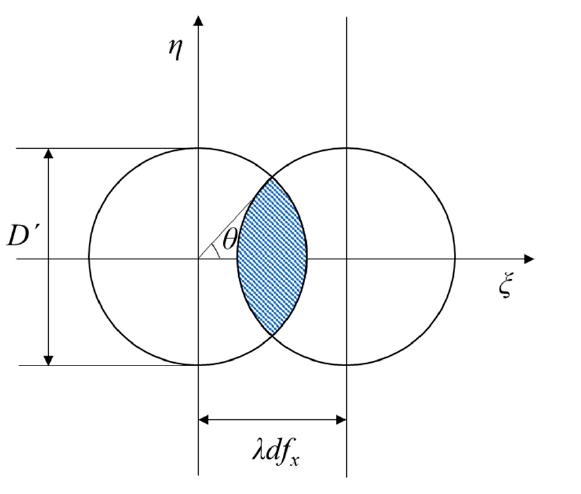
λ = 10 µ m, the relationship between the exit pupil diameter and the exit pupil distance is obtained as D (cid:48) / d i > 0.62.